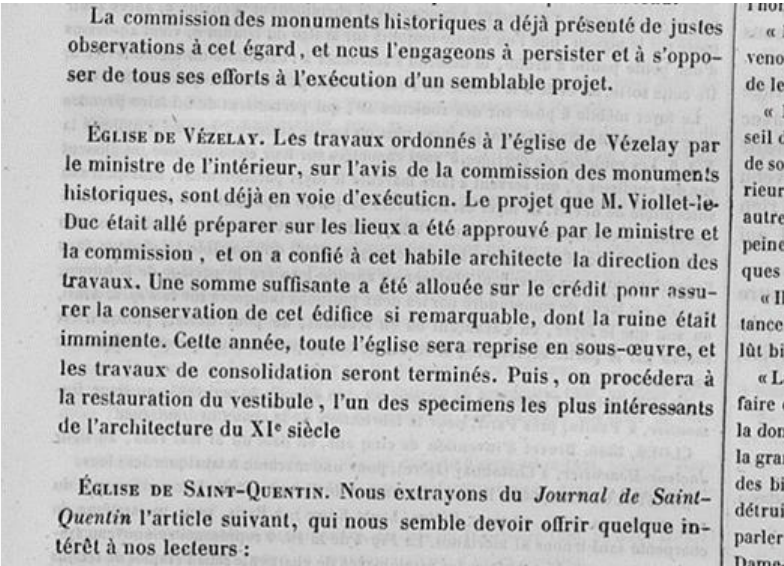
Figure 25. Church of Vezelay. Extract from the article “ Historic Monuments ” from the “ Revue General de l ’ architecture ” , 1840. Vol.4, col.241. Published by César Daly. Reference [46].